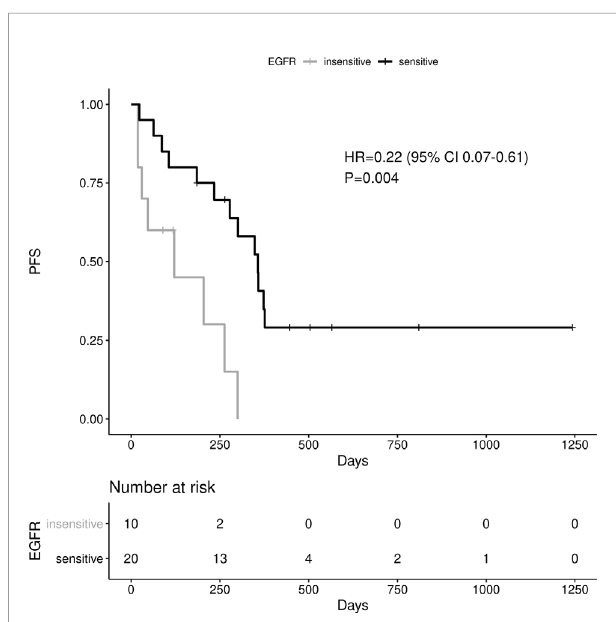
FIGURE 3 | Impact of tumor sensitivity on PFS.